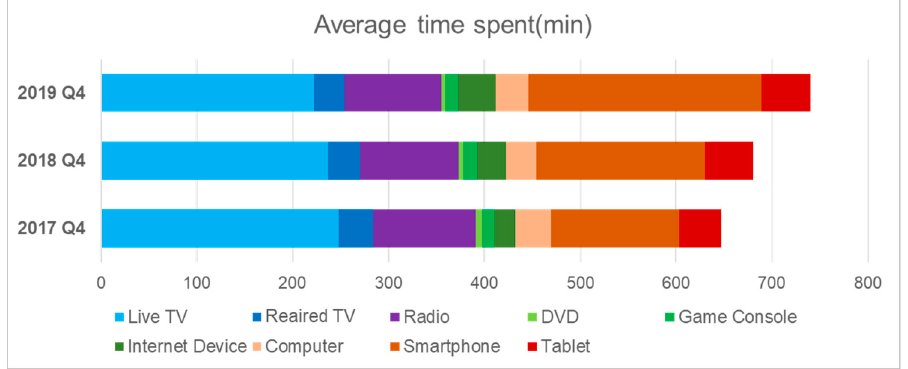
Figure 9. Average time spent per day [68] .